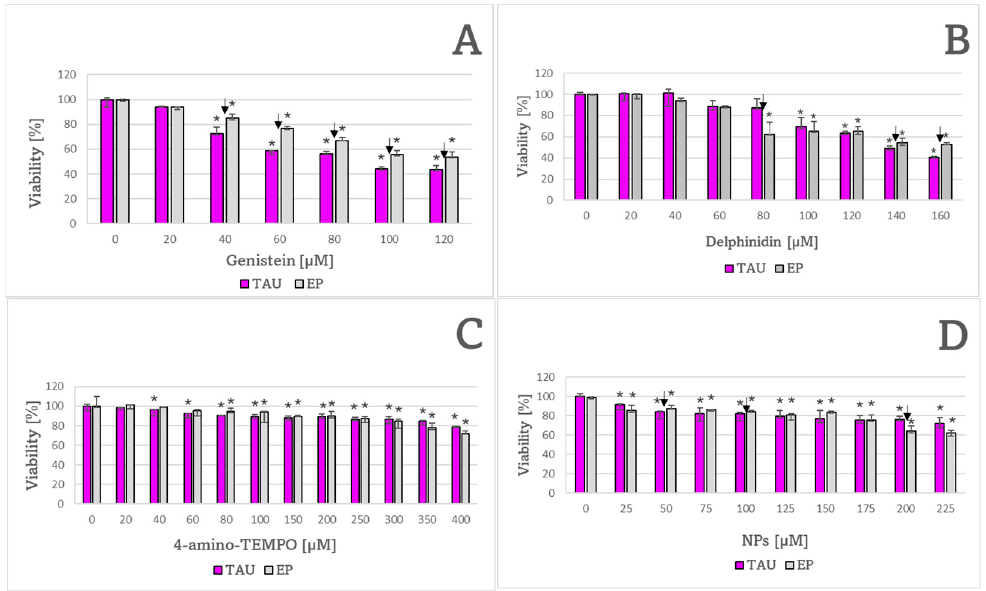
Figure 8. Sensitivity of TAU and EP cells to genistein ( A ), delphinidin ( B ), 4-amino-TEMPO ( C ), and NPs ( D ). * p < 0.05, compared to no treatment controls; ↓ p < 0.05, TAU cells vs. EP cells treated with the same concentration of the antioxidant; n = 3.